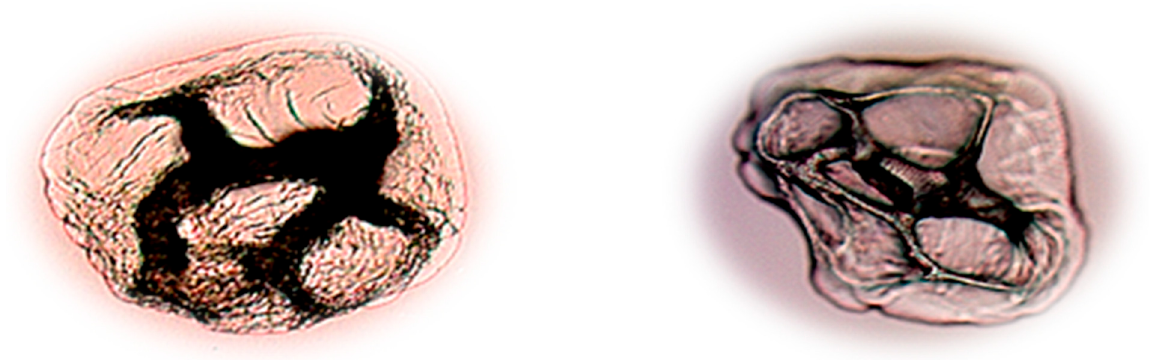
Figure 2. Microphotographs of microcapsules made by encapsulation with and without